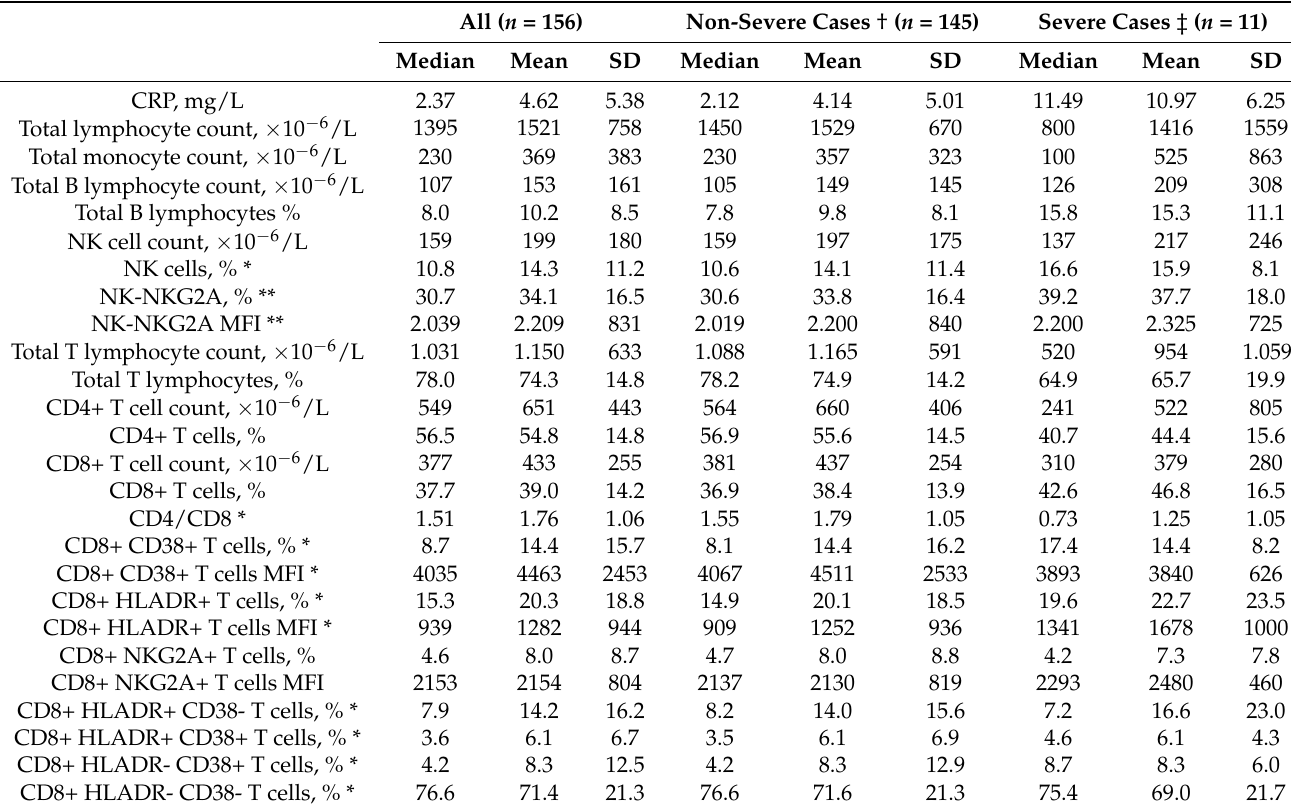
Table 2. Biomarker levels according to disease progression (WHO score